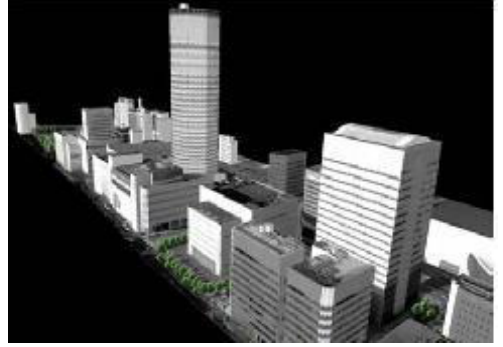
Fig.11. 3-D textured model of Yokohama City